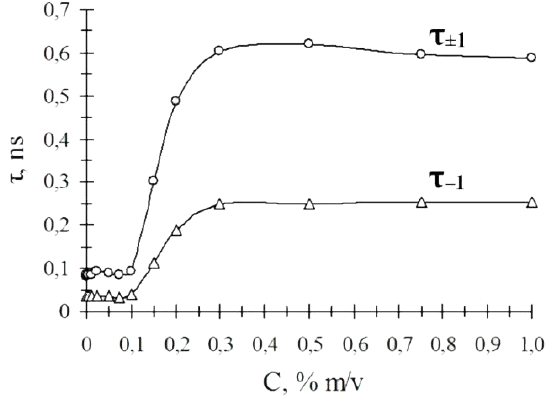
Fig. 4. Rotational correlation time (τ) of probe 1 vs concentration (C) of BC solutions